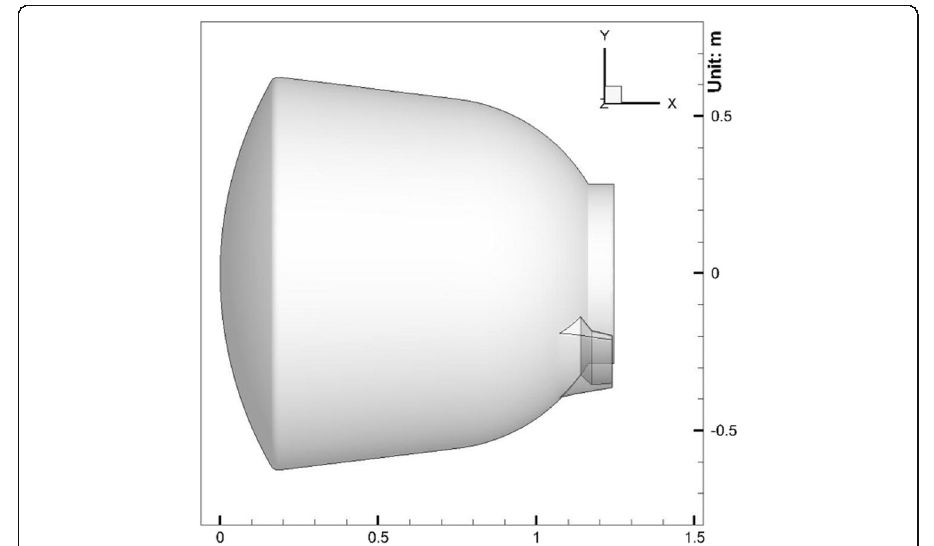
Fig. 15 Vehicle configuration of the Chinese lunar reentry capsule